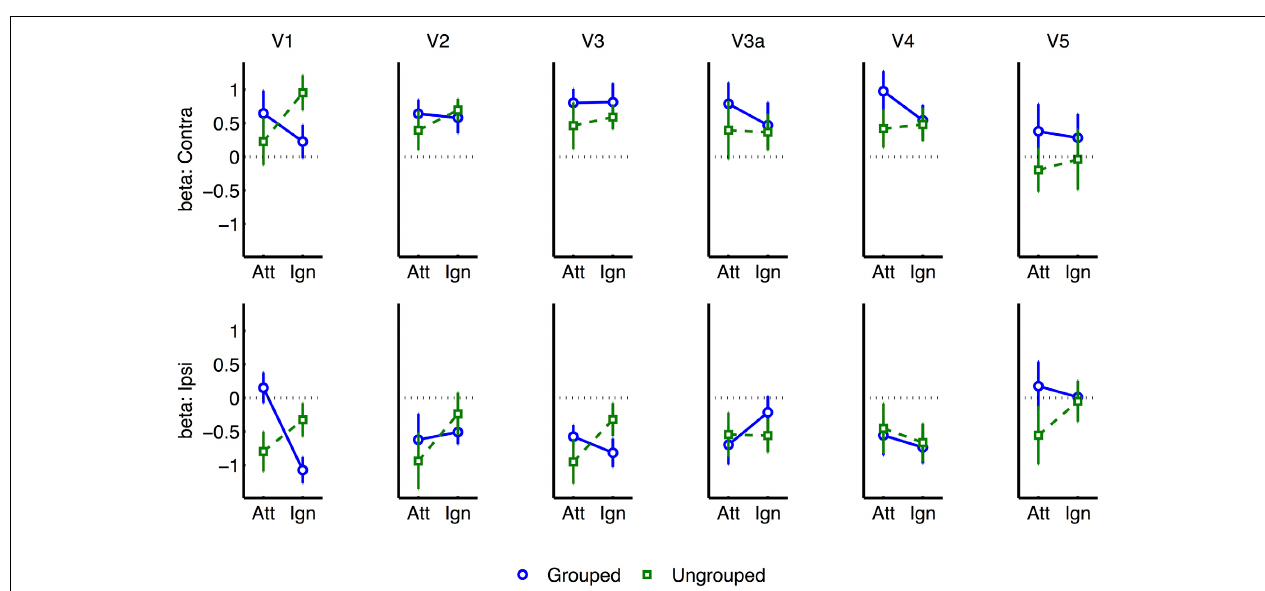
FIGURE 7 | Event-related normalized results for each visual region of interest, and for contralateral vs. ipsilateral transients.